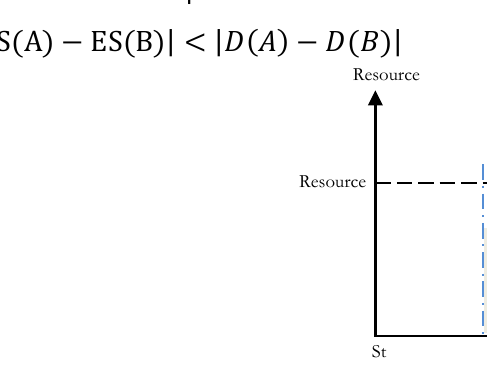
Fig. 7. A Graphical Sample of Unsteady Condition of